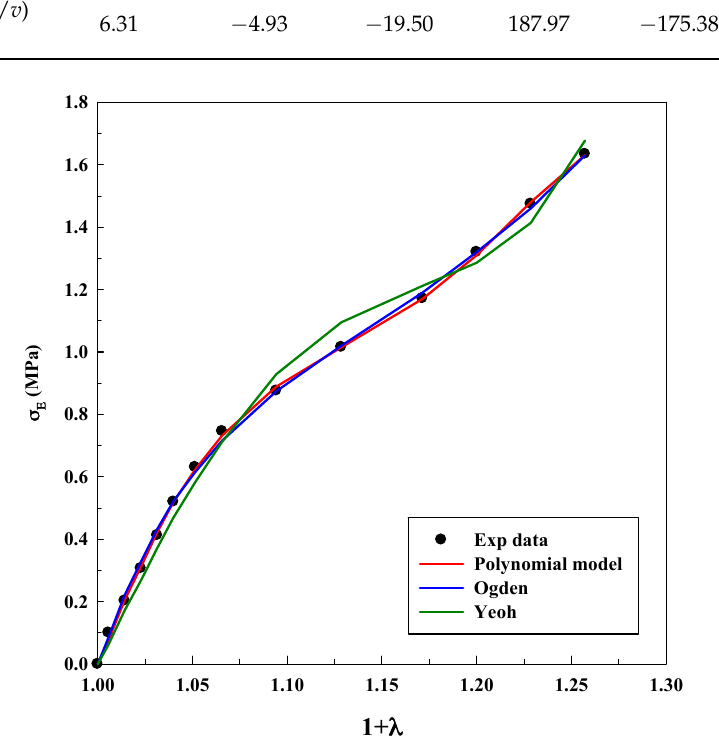
Figure 3. Models fitting of stress–elongation for the system A/G 20/80% v / v at 2% w / w .